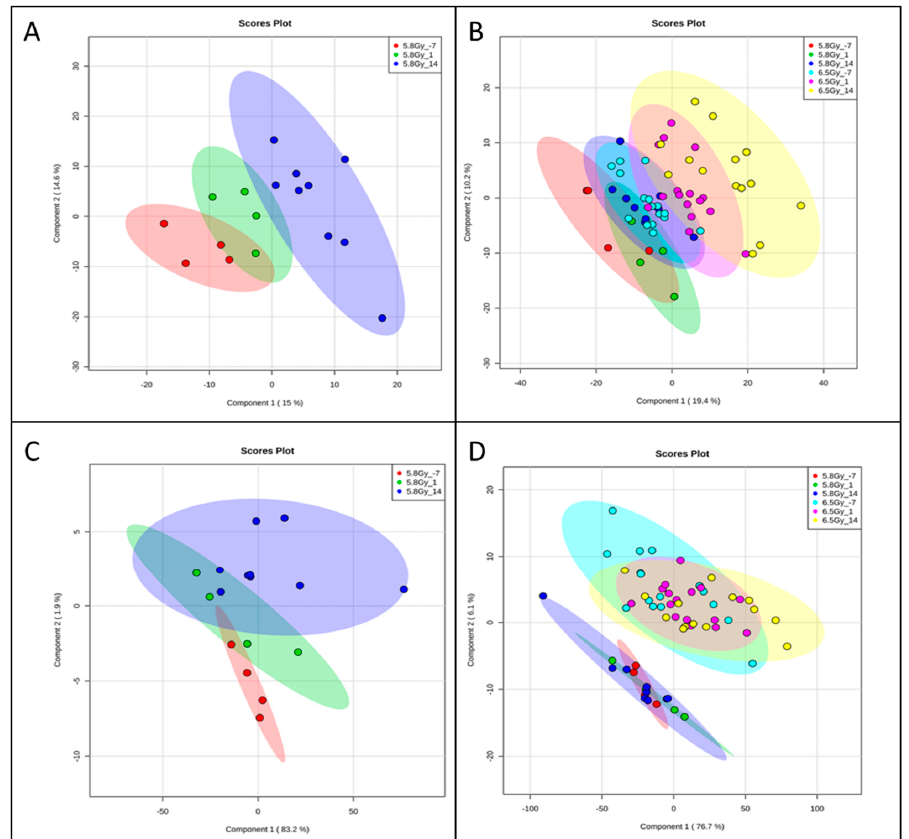
Figure 3. Group separation by total features in ( A ) plasma and ( B ) plasma-derived exosomes. Partial least squares discriminant analysis (PLS-DA) plots demonstrating separation by time and dose in plasma and plasma-derived exosome samples. All identified features were used. Though both plasma and exosomes were able to reasonably separate between pre- and post-irradiation, exosome feature profiles were superior at separating between doses. ( A ) 5.8 Gy plasma, ( B ) 5.8 Gy and 6.5 Gy plasma, ( C ) 5.8 Gy exosomes, ( D ) 5.8 Gy and 6.5 Gy exosomes. Representative data from electrospray positive (ESI+) ionization mode.